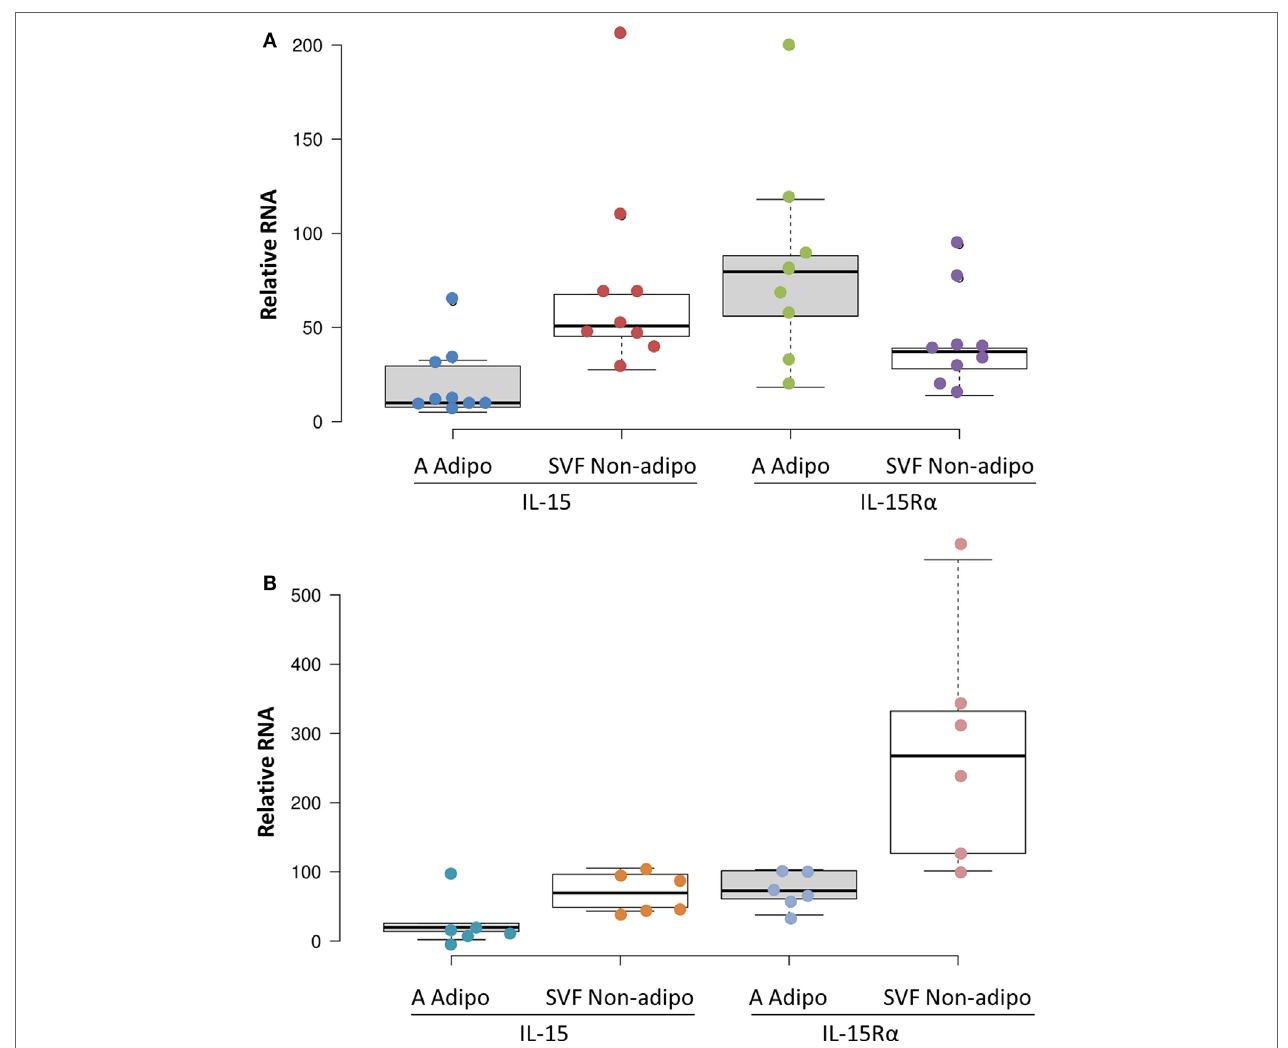
FigUre 4 | Subcutaneous adipose tissue (SAT) (a) and visceral adipose tissue (VAT) (B) stromal vascular fraction (SVF) cells produced more IL-15 RNA than did adipocytes ( p = 0.012 and p = 0.043, respectively, by Wilcoxon Signed Rank Test) in cohort B. IL-15R α RNA levels did not significantly differ between SVF and adipocytes. Adipocyte (A Adipo) and non-adipocyte (SVF Non-adipo) were calculated to exclude contaminating cells as described in Section “Materials and Methods.” All but one SAT samples were from female patients. SAT samples were from breast reductions (5), panniculectomy (4), and ventral hernia repair (1). None of the SAT cases involved cancer or other inflammatory diseases. VAT samples were from colectomies (5), exploratory laparotomy (1), and gastrectomy (1). Two VAT cases did not involve cancer. Cohort B is described in Table S1 in Supplementary